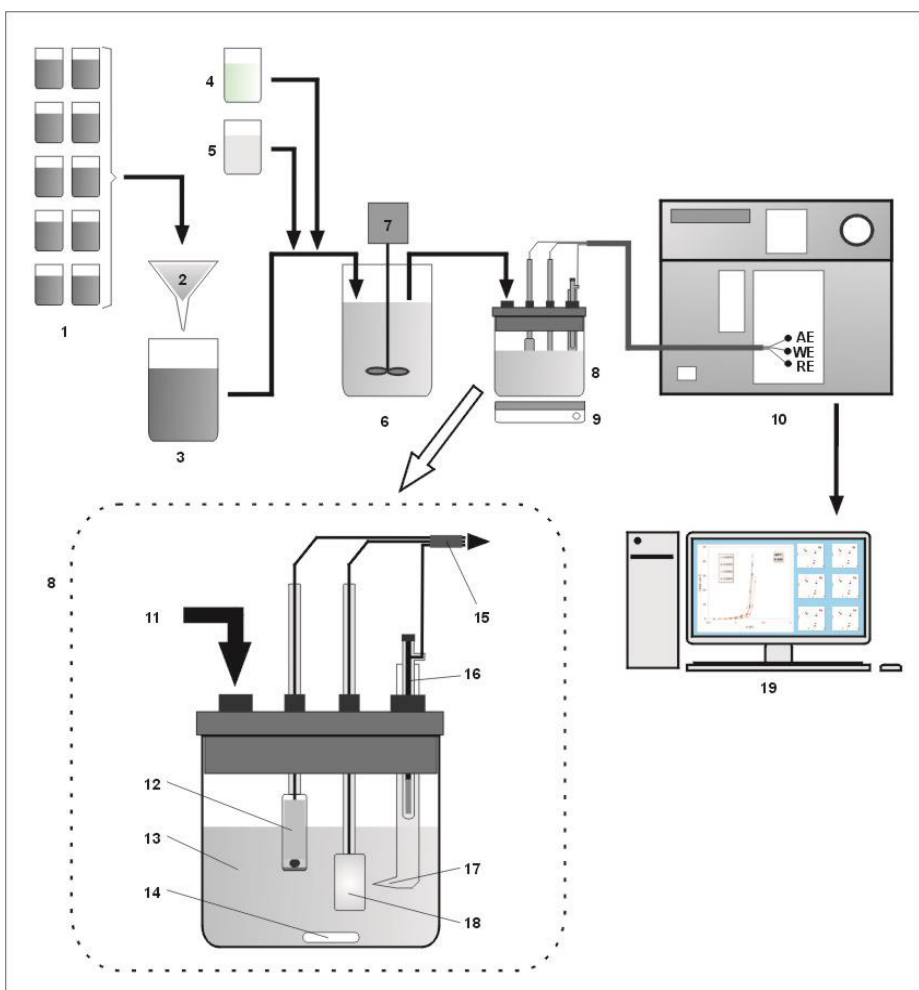
Figure 1. Measurement setup for the analysis of waste engine oil electro-oxidization: 1—waste engine oil samples; 2—filtration; 3—mixed oil; 4—water; 5—detergent (Syntanol DS-10); 6—emulsion preparation (mixing of waste engine oil samples with water and detergent); 7—mechanical stirrer; 8—reactor (electrochemical cell); 9—magnetic stirrer; 10—potentiostat (AMEL System 5000); 11—waste engine oil emulsion or pure detergent; 12—auxiliary electrode (AE); 13—electrolyte (aqueous solution of H 2 SO 4 ); 14—stirrer bar; 15—electrical connections to the potentiostat; 16—reference electrode (RE); 17—Luggin capillary; 18—working electrode (WE); 19—computer.